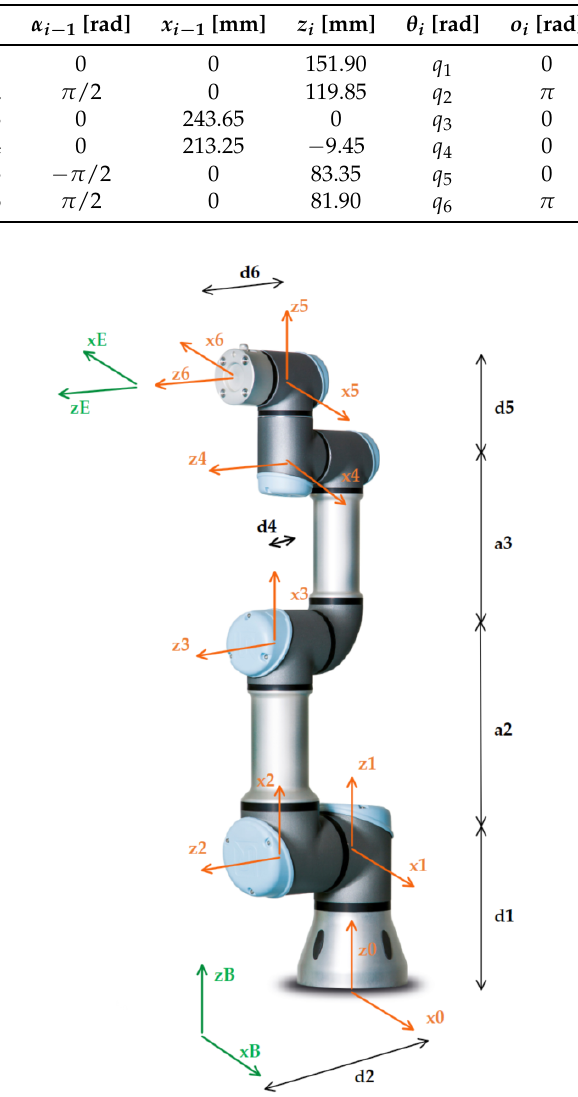
Figure 1. UR3 with coordinate frames according to